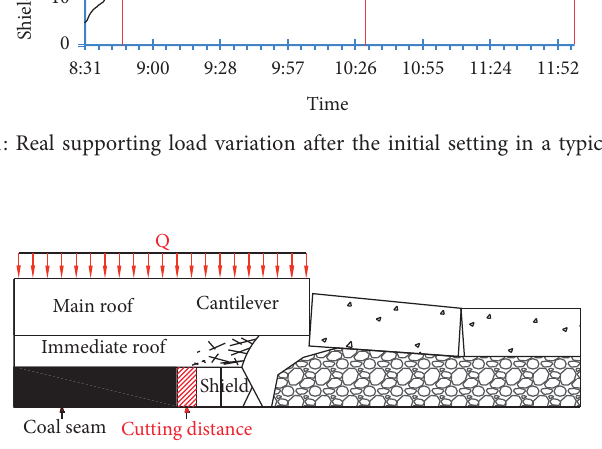
Figure 2: Engineering structure around Longwall Panel.